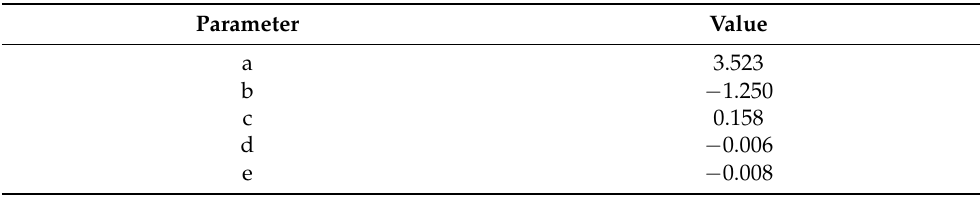
Table 6. Values of equation parameters for bias-ply tire.